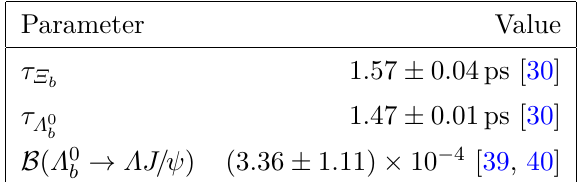
Table 1 . Input parameters used to compute the branching fraction B ( Ξ −